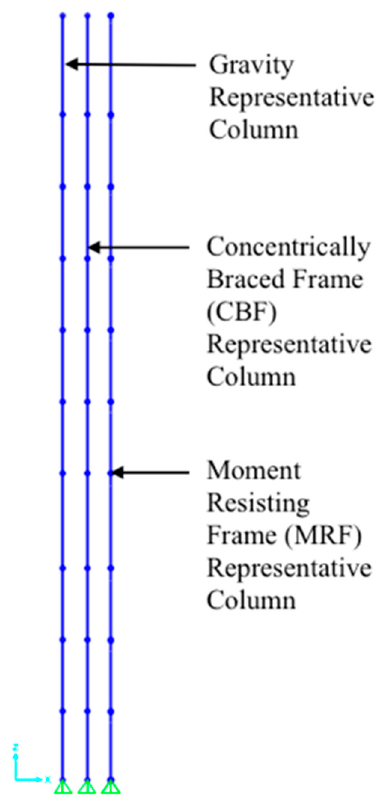
Figure 2. Representative column model placement.